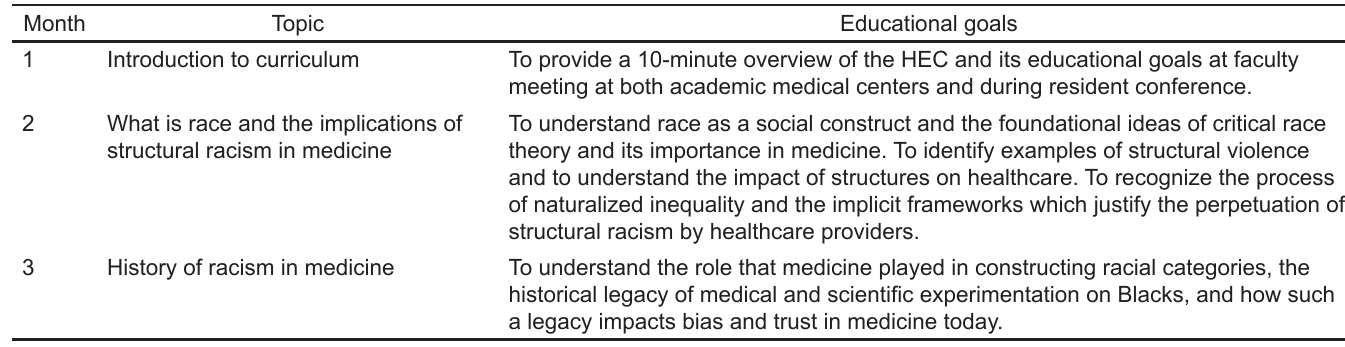
Table 1. List of covered Health Equity Curriculum (HEC)